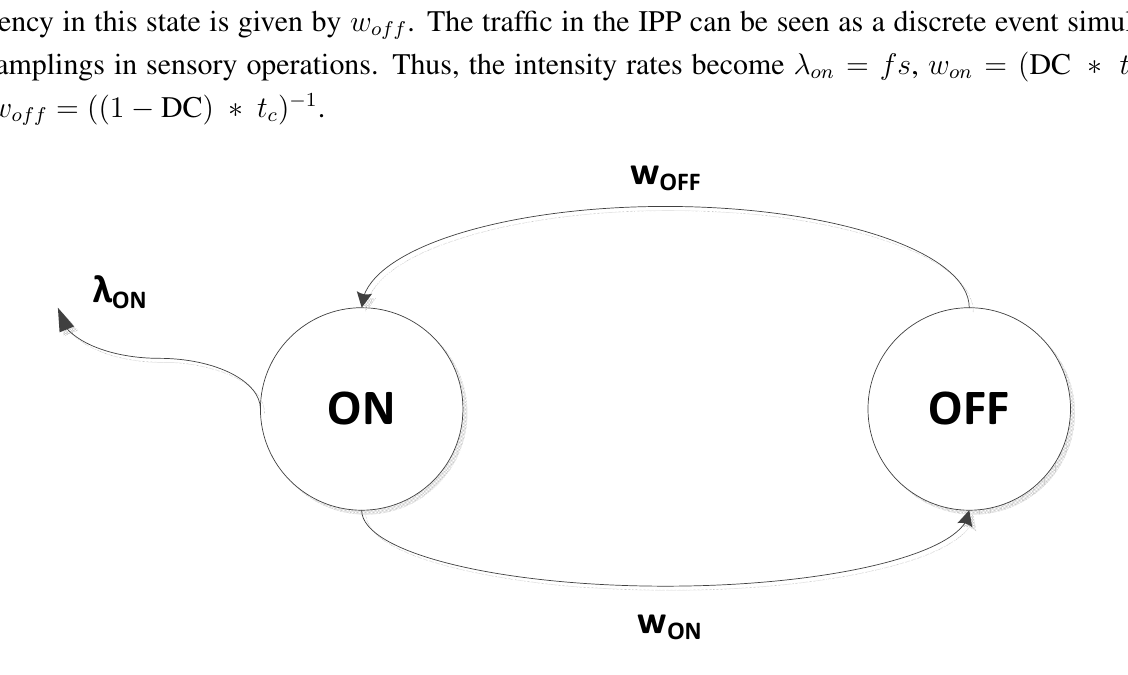
Figure 3. Interrupt Poisson process